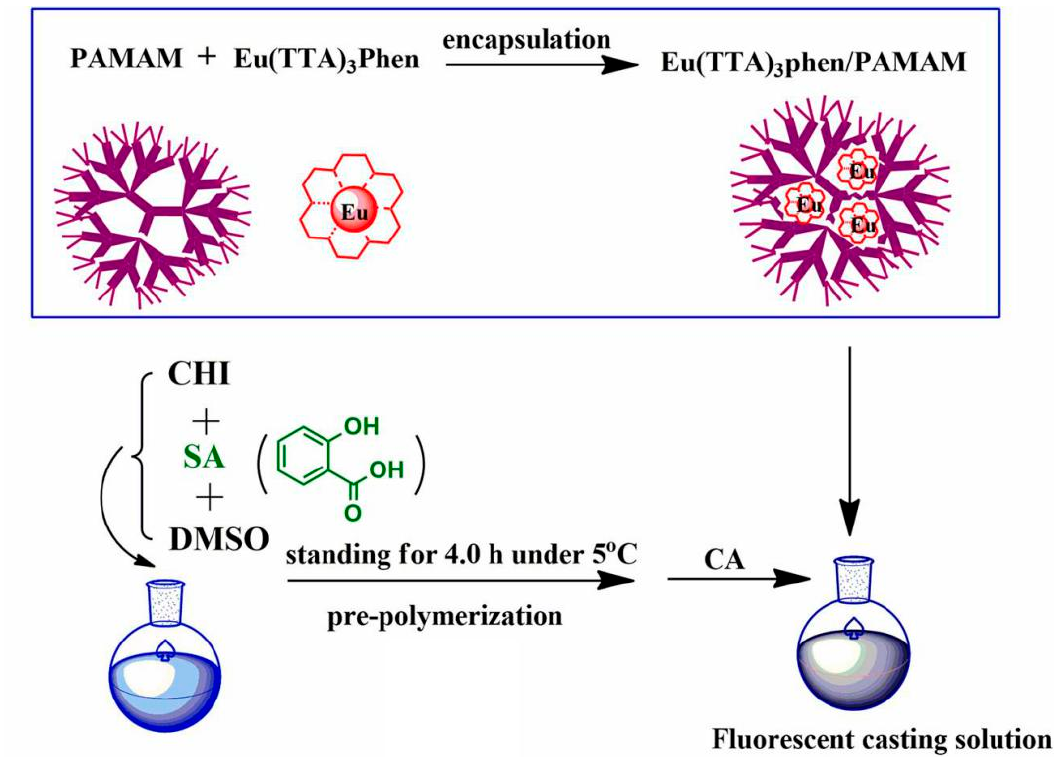
Figure 10. Scheme of formation of FMIM and its fluorescent mechanism. Reproduced with permission from [46].